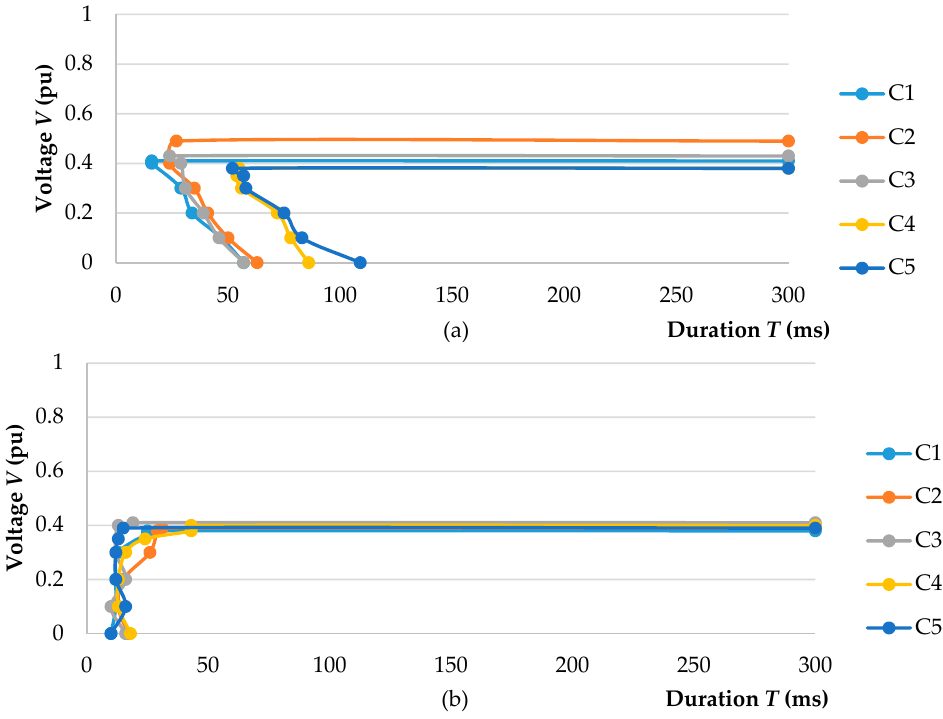
Figure 5. Voltage–tolerance characteristic of contactors: ( a ) at phase instant of voltage 0°; and ( b ) at phase instant of voltage 90°.